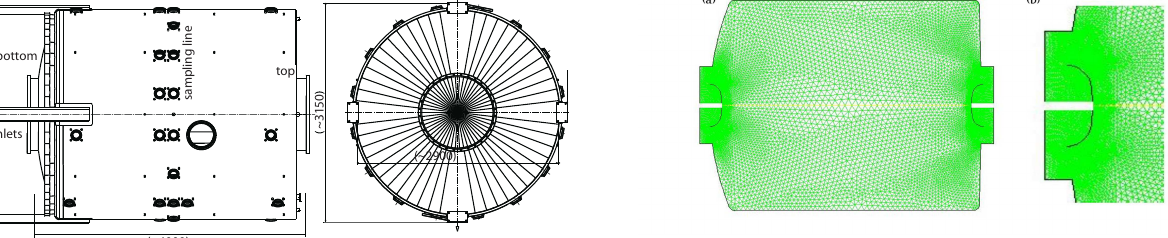
Fig. 1. Schematic diagram of the CLOUD chamber, a stainless steel cloud tank with 26.1m 3 . According to the figures shown in the following, the front view of the tank was rotated by 90 ◦ (clockwise). At the mid-height, the holes for the sampling probes (sampling line) are visible.